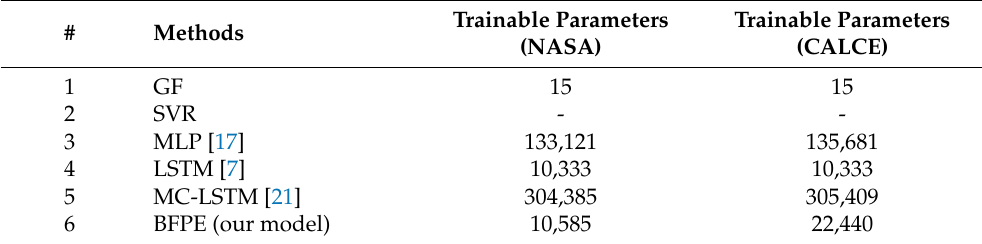
Table 3. Summary of comparison of complexity and processing